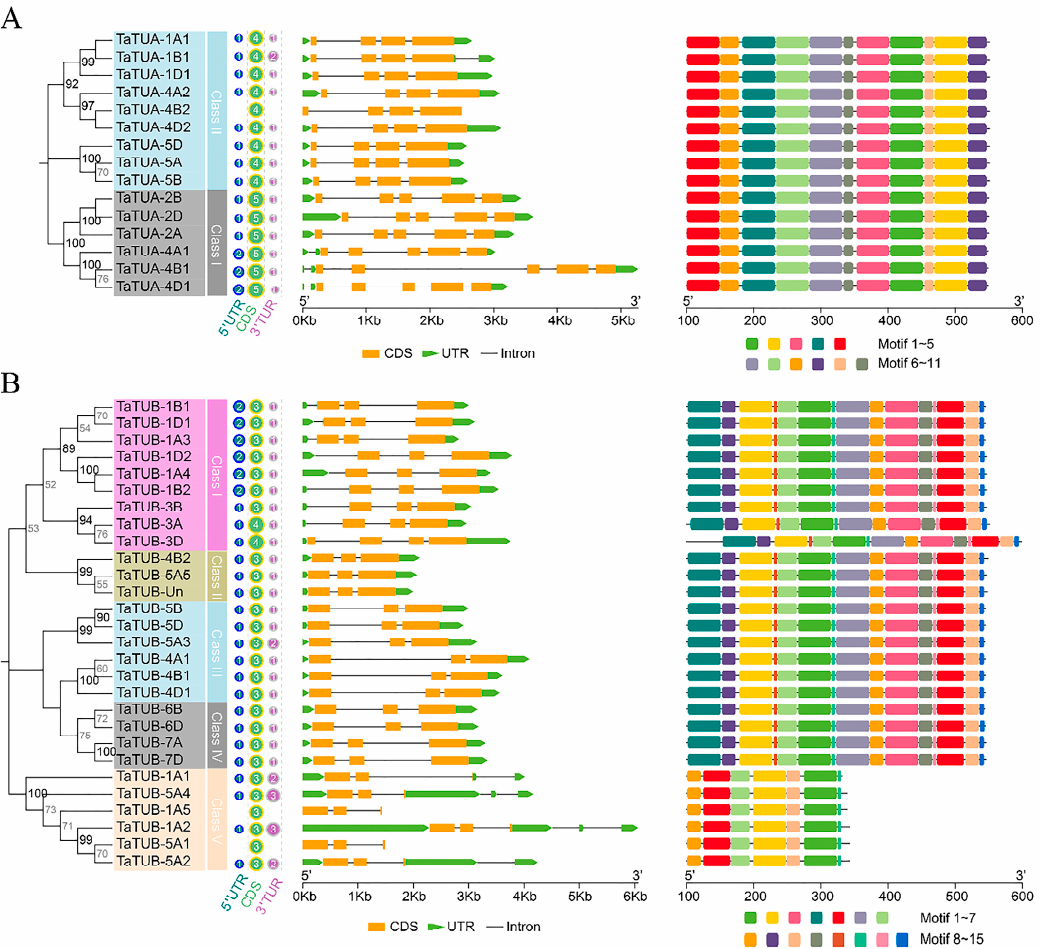
Figure 4. Phylogenetic relationships, gene structure, and architecture of conserved protein motifs in the TaTUA ( A ) and TaTUB ( B ) genes. The phylogenetic tree was constructed using the maximum likelihood (ML) method. The evolutionary distances of TaTUA and TaTUB genes were computed using the JTT and WAG matrix-based